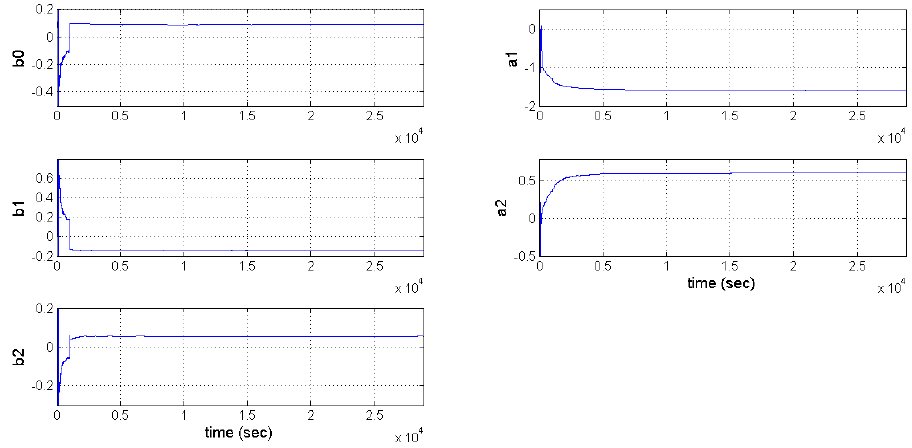
Figure 10. The estimated parameters of a discrete transfer function G ( z ).